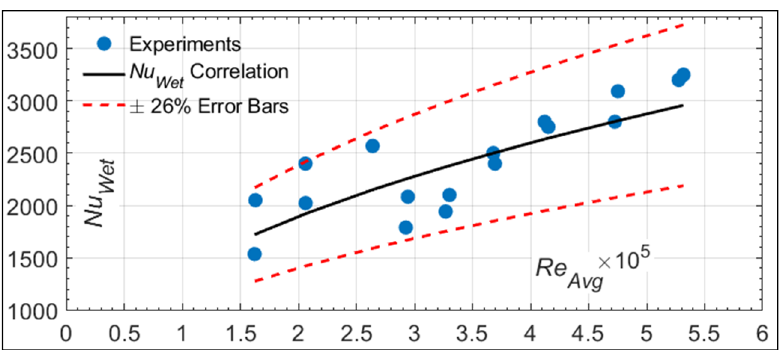
Figure 21. Comparison of Correlation Predictions versus Experimental Measurements for Nu Wet.